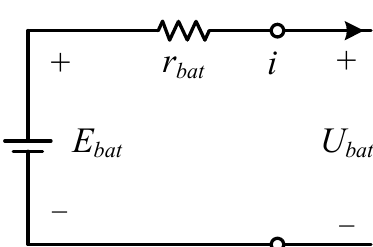
Figure 3. Equivalent circuit of battery.